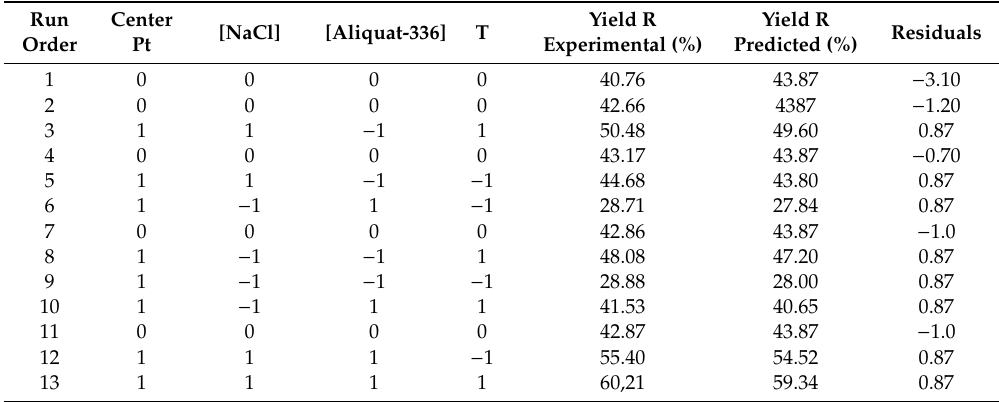
Table 5. Receiving phase matrix of